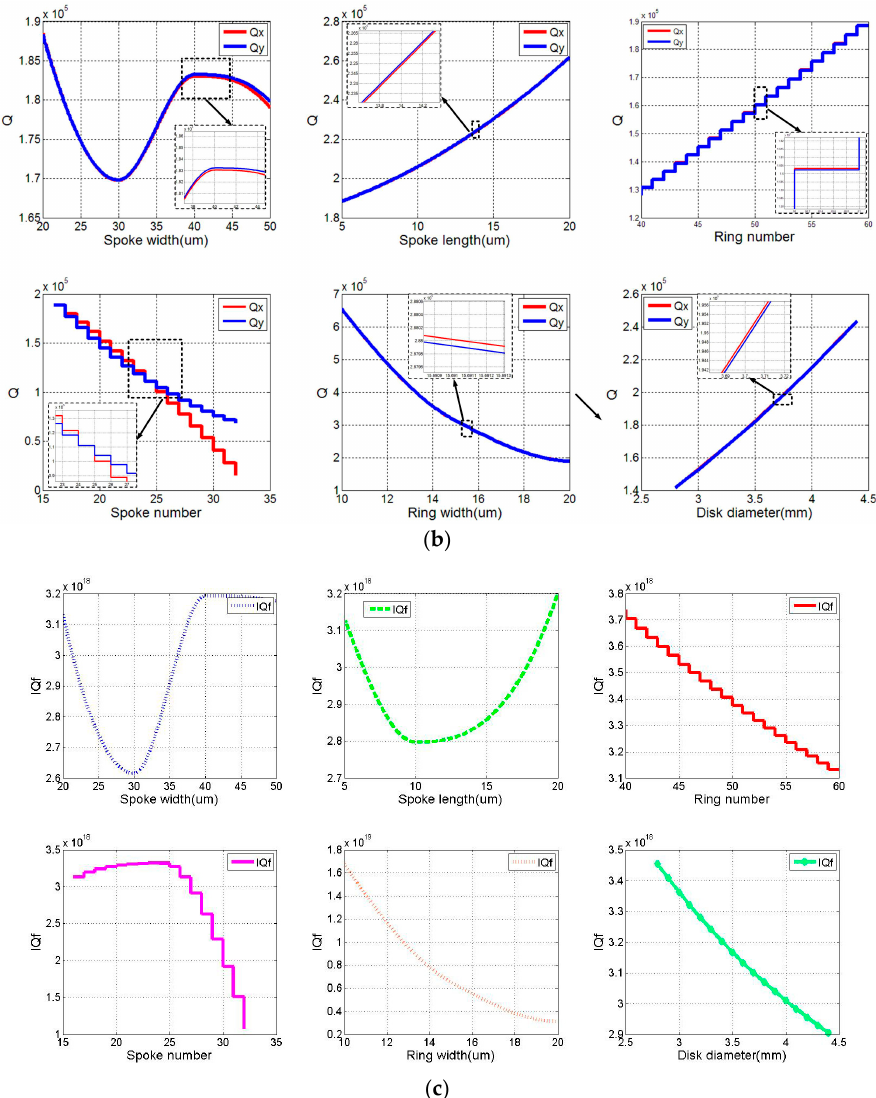
Figure 7. Simulation results in COMSOL Multiphysics. ( a ) Temperature departure of DRG in drive and sense modes ( n = 2), ( b ) Simulation results of Q TED in DRG, and ( c ) Simulation results of I Qf in DRG.